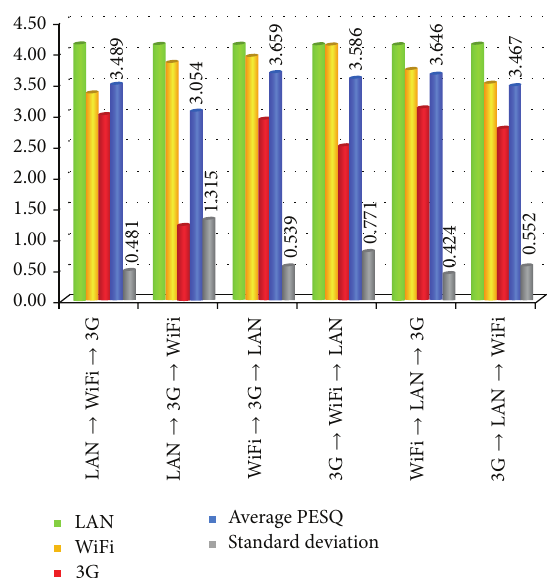
Figure 10: The result of different broadcasting